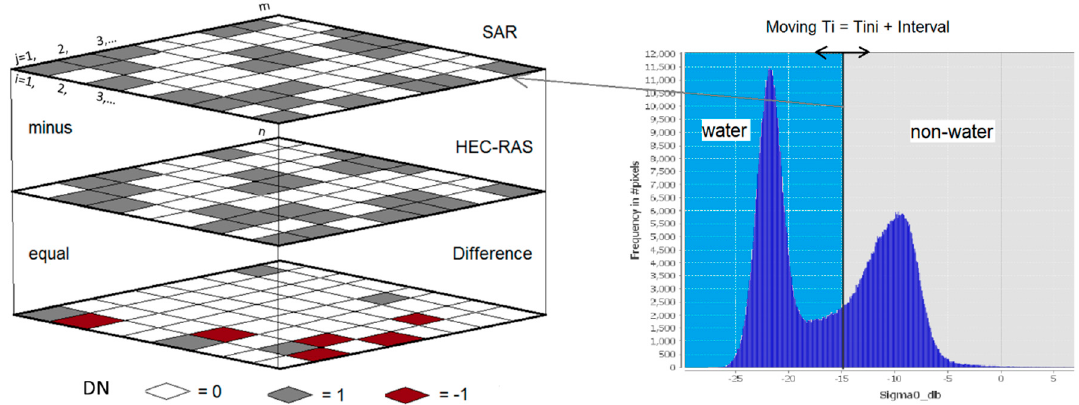
Figure 4. Graph of the Hammock Swing Thresholding (HST) concept determining an optimal SAR threshold of water masking. HEC-RAS stands for the Hydrologic Engineering Centers River Analysis System model. DN is a digital number, where 0 represents a perfect match between SAR and the model outputs, 1 represents underestimation of the water extent by SAR, and − 1 represents overestimation of the water extent by SAR. Ti is the threshold dB value i, Tini is an initial threshold, and m and n are numbers of pixel columns and rows, respectively, that vary in different types of SAR images.